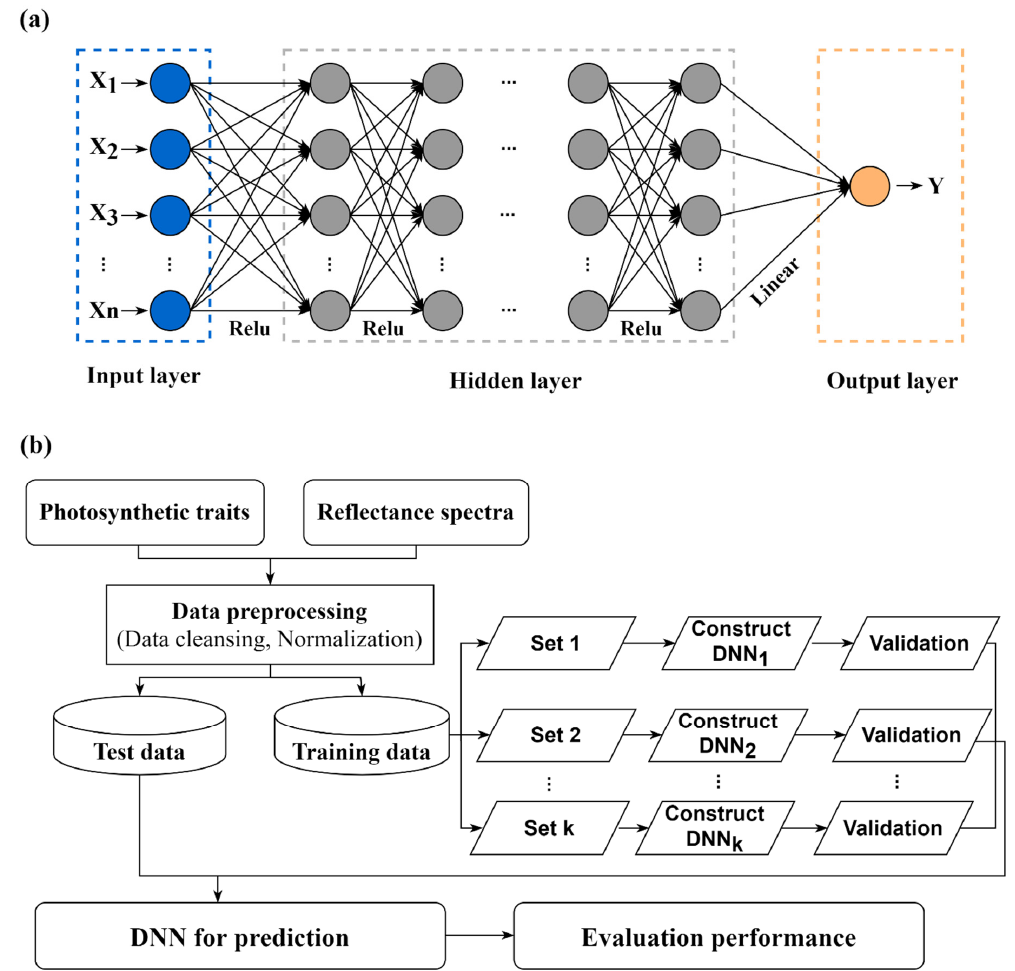
Figure 2. The structure of the deep neural network (DNN) ( a ) and the flowchart of the ensemble DNN model with the bootstrap sampling approach ( b ) for predicting the maximum carboxylation rate ( V cmax) and maximum electron transport ( J max) in this study.